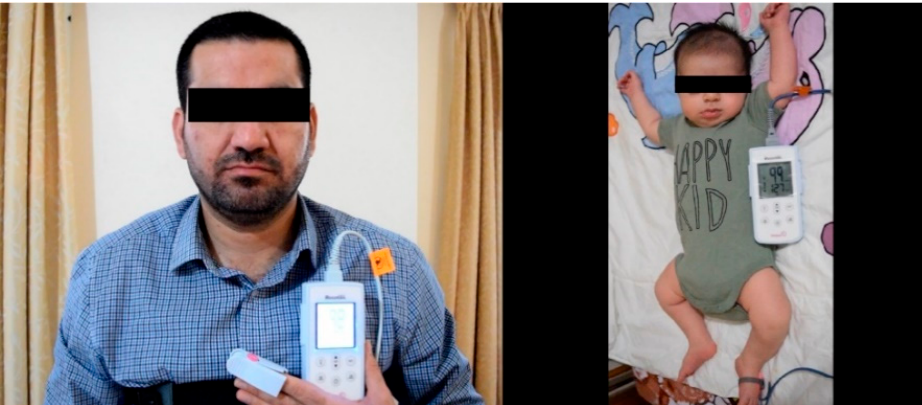
Figure 2. Video recordings from two participants using Nikon 3500 digital camera.